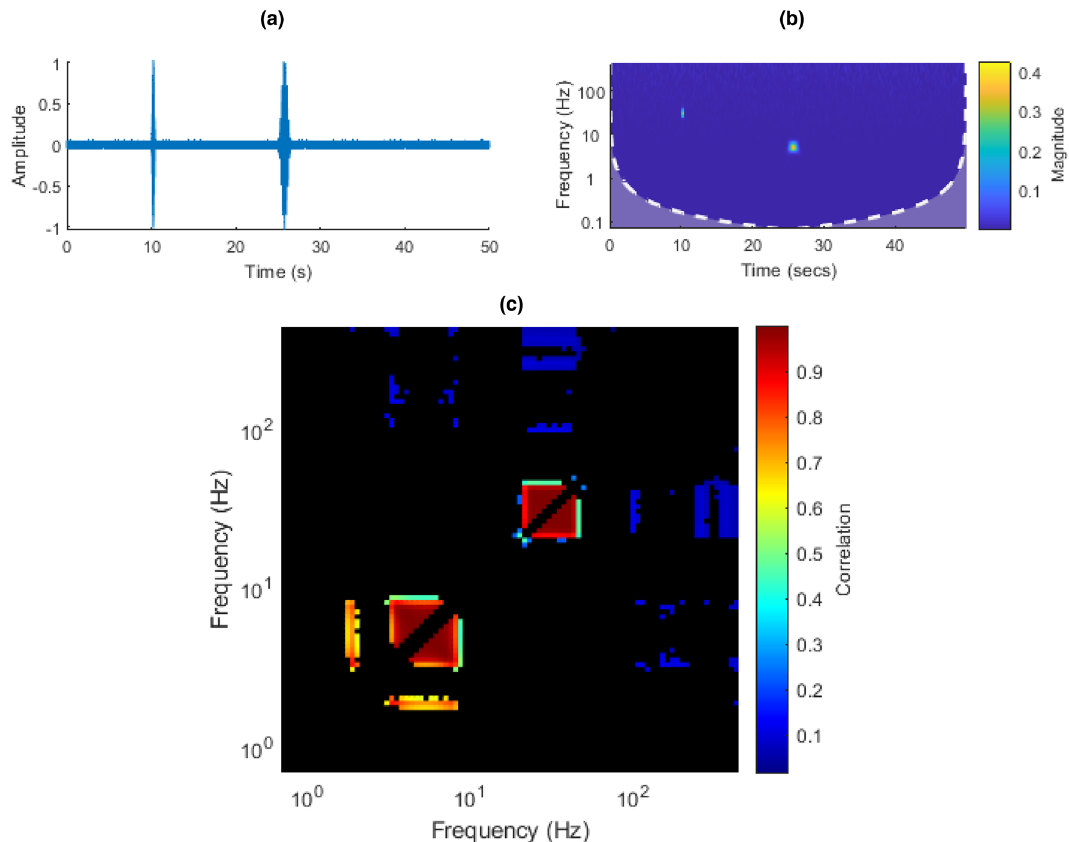
Figure 14. ( a ) Double-pulse time domain plot. ( b ) Double-pulse CWT. ( c ) Double-pulse ISPCM, black elements represent non-statistically significant correlations at an FDR α of